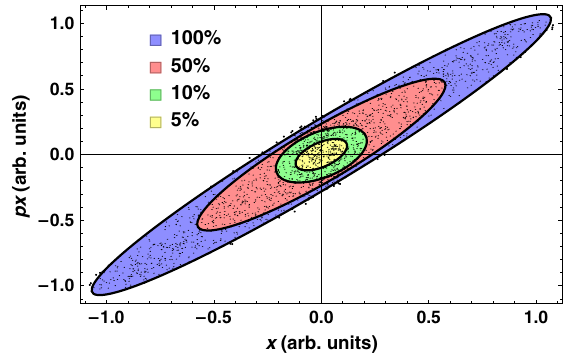
FIG. 6. Depiction of emittance vs particle fraction selection. Ellipses are drawn such that they represent the phase space area occupied by the beam using only a given fraction of the total number of particles. Ellipse dimensions are selected such that the emittance is minimized for each particle